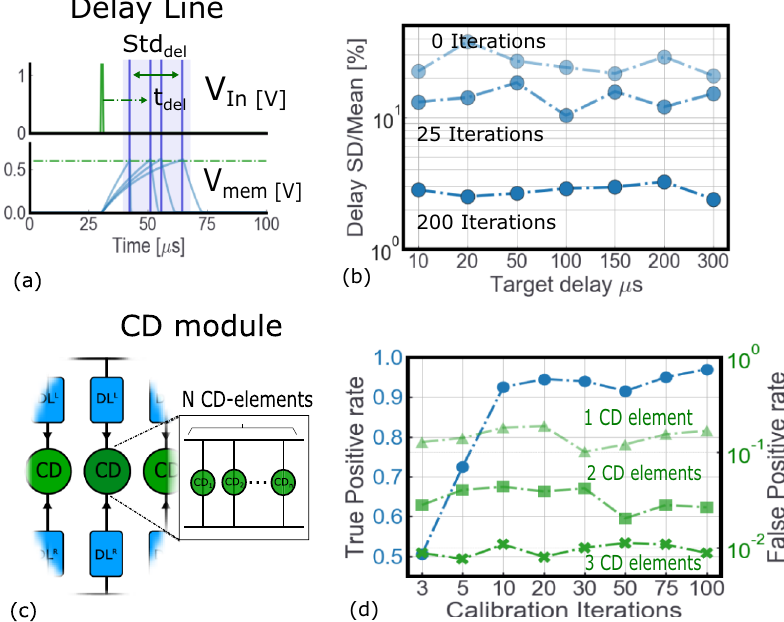
Fig. 6 Performance of the delay line and direction insensitive CD circuits and impact of the RRAM calibration procedure. a Impact of the neuron variability on the delay line circuit. b The delay line circuit can be scaled up to larger delays, setting the time constant of the corresponding LIF neuron and DPI synapse to larger values. Increasing the iterations of the RRAM calibration procedure enabled us to substantially improve the precision on the target delay: 200 iterations allow the error to be reduced to less than 5%. One iteration corresponds to a SET/RESET operation on the RRAM cell. c Each CD module in the Jeffress model can be implemented with N -parallel CD elements, to be more resilient to system failures. d More RRAM calibration iterations allow to improve the true positive rate (blue line), while the false-positive rate is independent of the number of iterations (green lines). Stacking more CD elements in parallel enabled us to avoid false coincidence detection from a CD